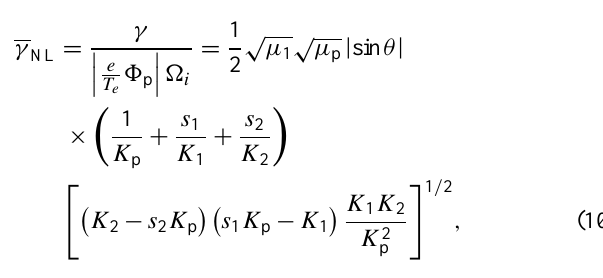
perpendicular wavenumber squared µ 1 and angle θ between k 1 ⊥ and k p ⊥